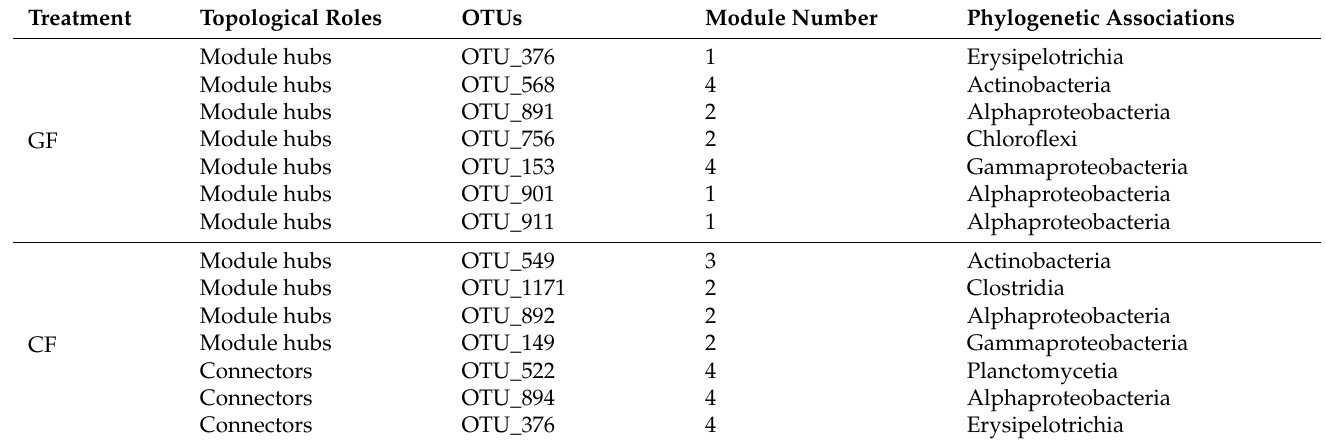
Table 3. Topological roles of intestinal microbiota in grass carp.